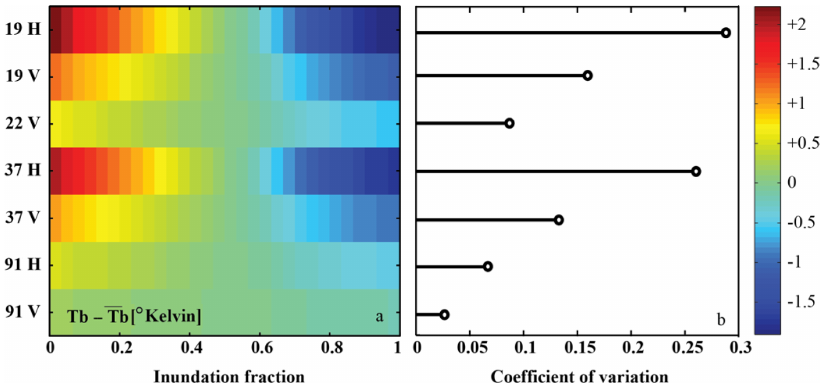
Figure 5. The normalized coefficients of variation (right panel) of the brightness temperatures (Tb) (left panel) averaged over the entire dataset for different intervals of inundation fractions. Here, ¯ Tb denotes the average of brightness temperatures over the inundation fractions. The coefficients of variation of each channel are used to determine the channel weights for the retrieval algorithm. Channels 19HGHz and 37VGHz are the most responsive channels to the variability of inundation fraction and are given higher